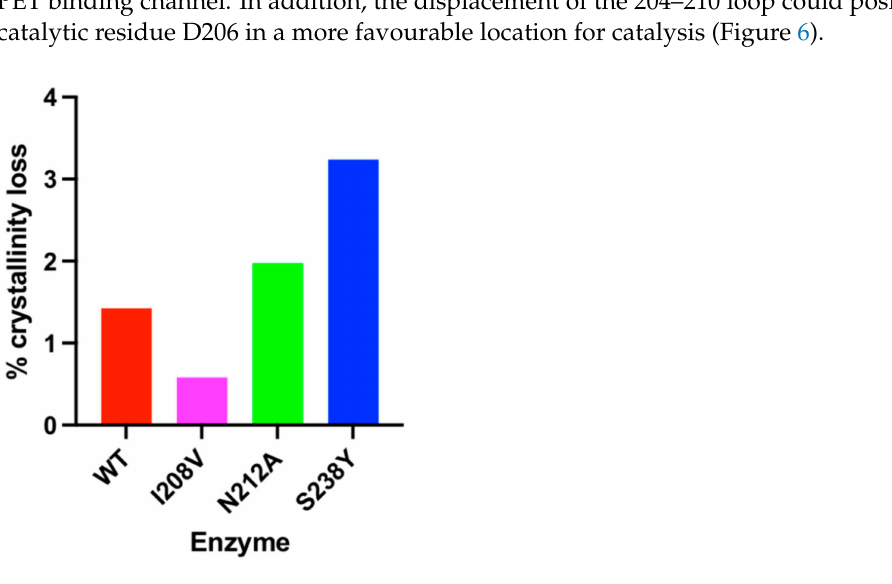
Figure 5. Engineered Is PETase provoke changes in the crystalline structure of PET. The crystallinity of enzyme-treated PET was analysed by DSC.